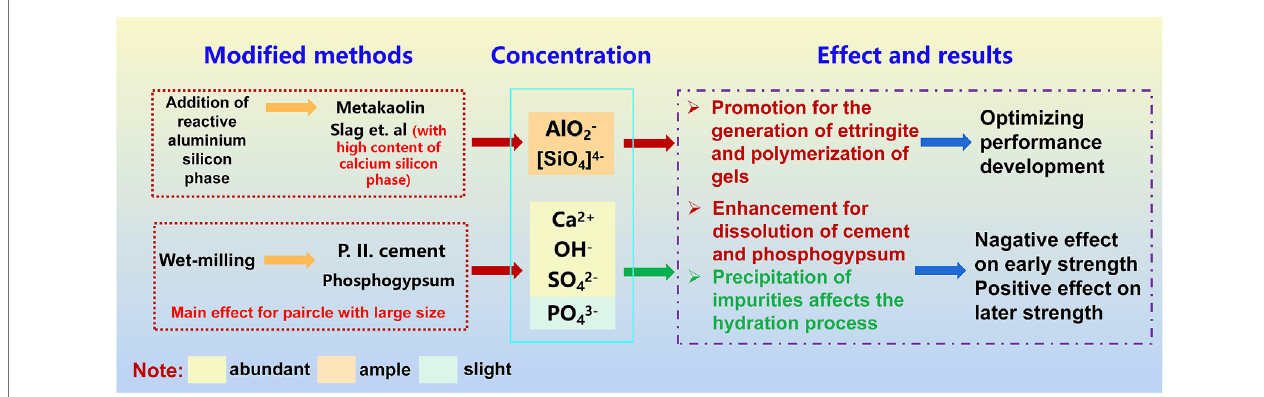
FIGURE 15 | Effect of wet grinding and incorporated aluminum phases on the hydration of P-SSC